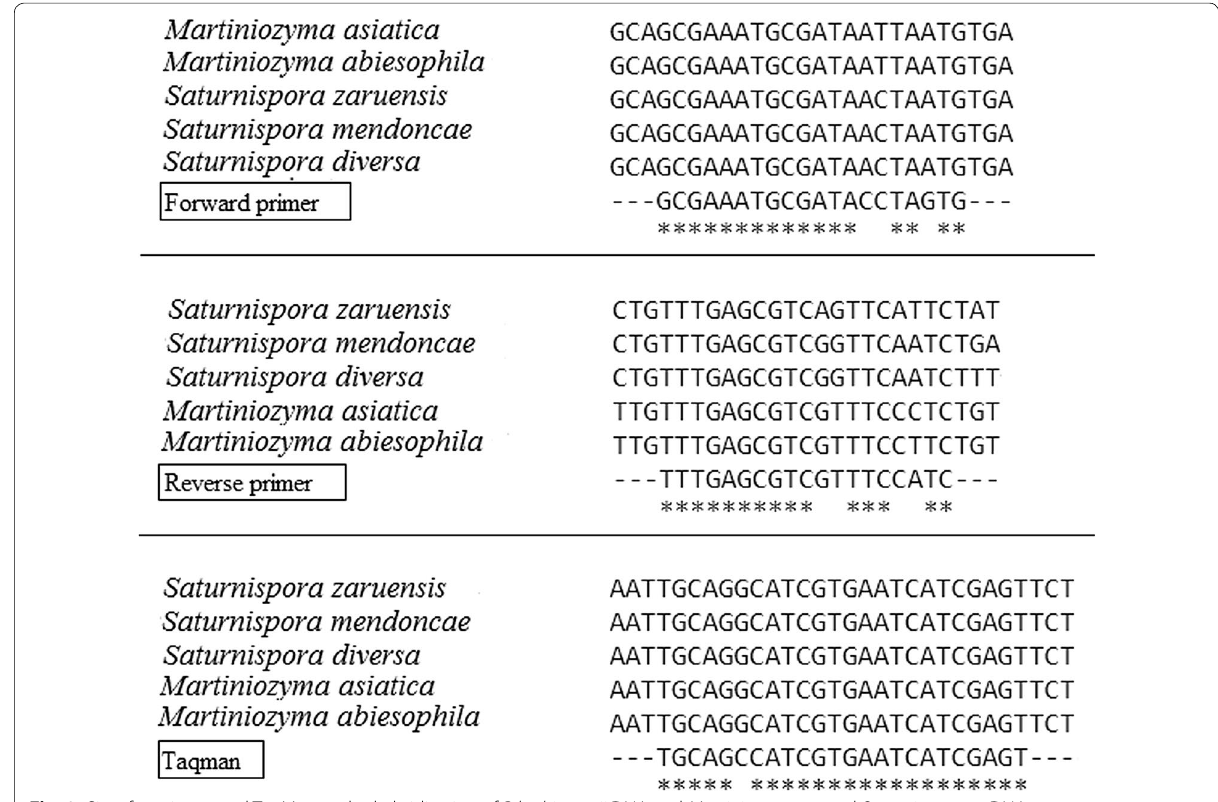
Fig. 2 Sites for primers and TaqMan probe hybridization of P. kudriavzevii DNA and Martiniozyma sp. and Saturnispora sp. DNA